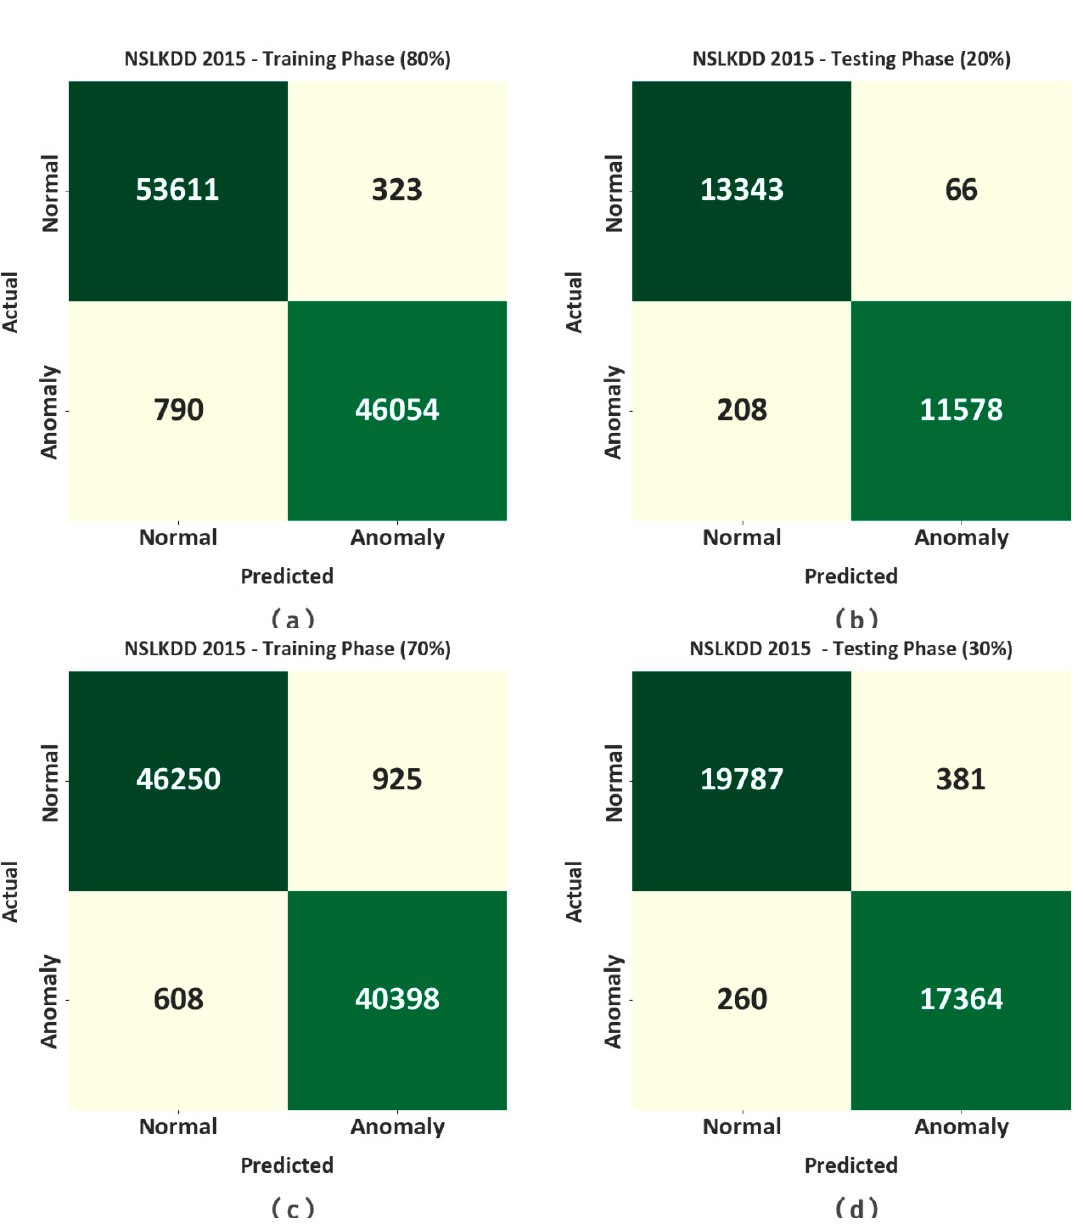
Figure 3. Confusion matrices of XAIID-SCPS system on NSLKDD2015 dataset ( a , b ) TRS/TSS of 80:20 and ( c , d ) TRS/TSS of 70:30.